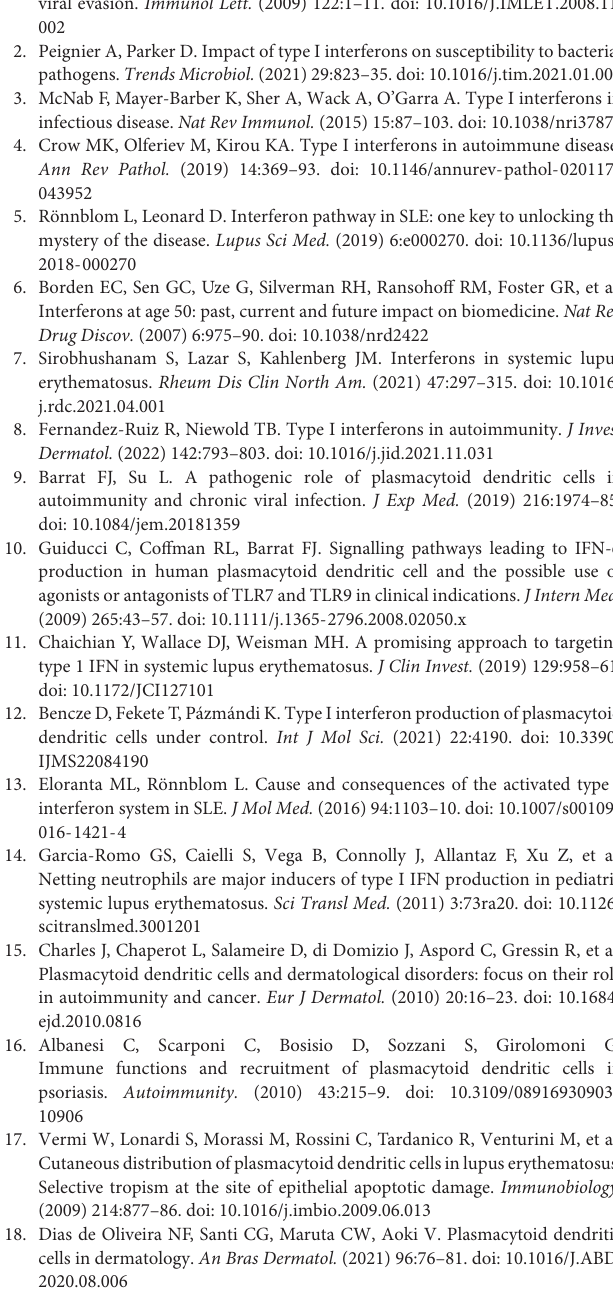
Representative plots of pDCs for each study group are shown by using CD123 and BDCA4 markers. HD, healthy donor; NR, non-reactional multibacillary patient; and ENL, erythema nodosum leprosum. Supplementary Figure 2 | Gating strategy and representative histograms of TLR9 and TLR7 levels in pDCs. Lumps and doublet cells were excluded using the parameters of frontal dispersion measured by area (FSC-A, forward scatter-area),